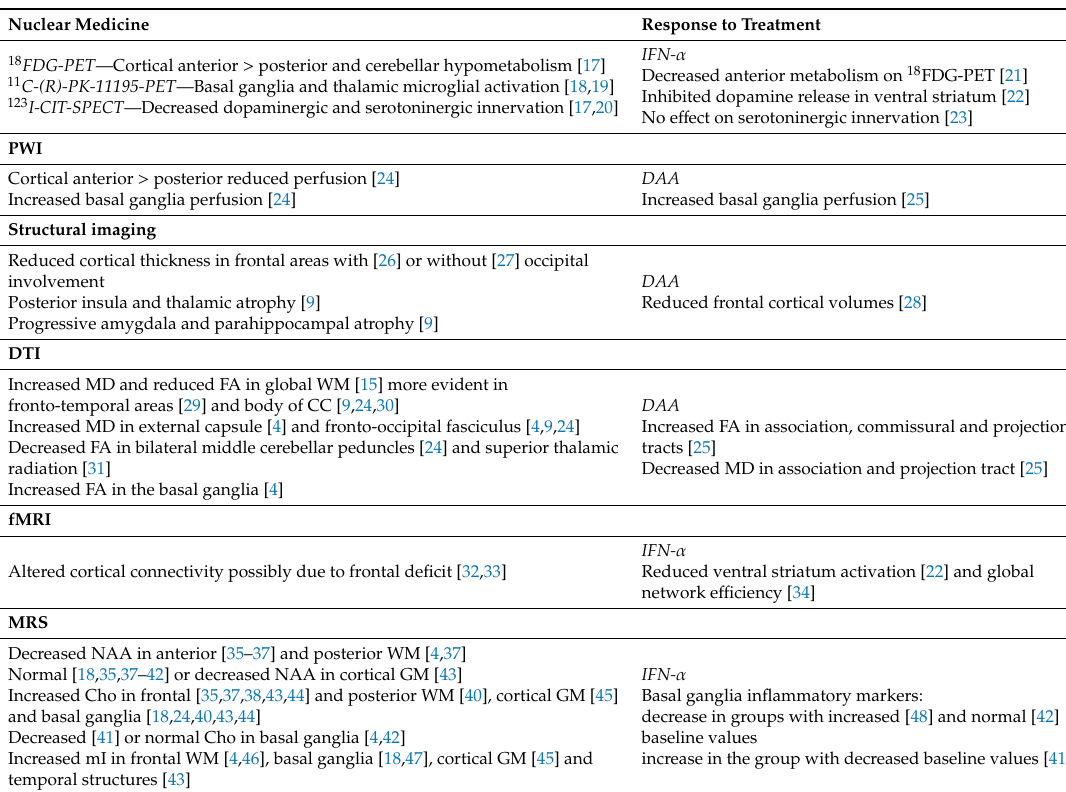
Table 2. Summary of the imaging findings in